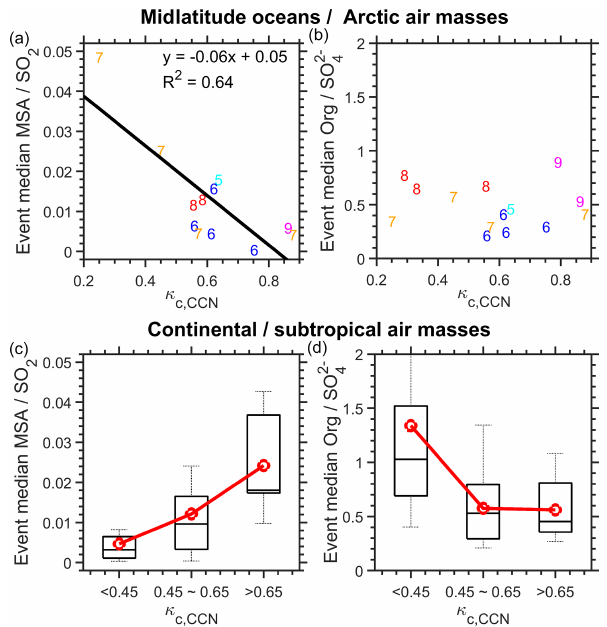
Figure 6. Potential sources of the condensing organics. Correlations of the derived κ c , CCN with (a, c) the MSA / SO 2 ratio and (b, d) the non-refractory PM 1 organics / SO 2 − ratio, for (a, b) the clean air 4 masses from the midlatitude Atlantic or Arctic and (c, d) the conti- nental or subtropical air masses. Numbers shown in (a, b) indicate the month in which the growth events